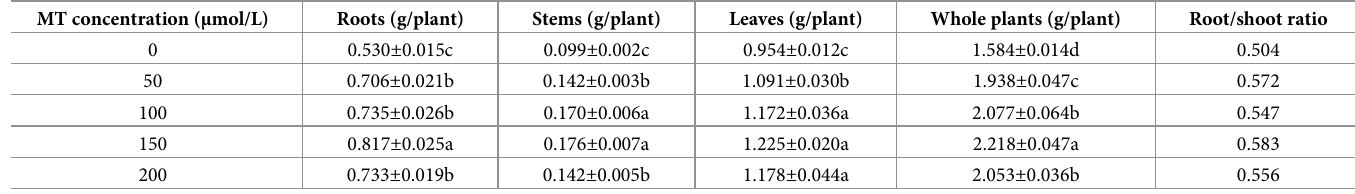
Table 1. Biomass of grape seedlings.